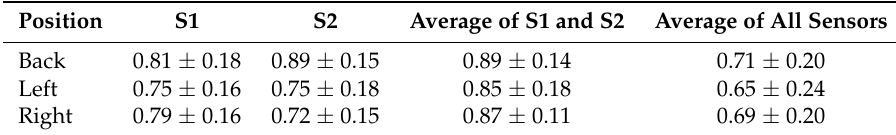
Table 2. Results of precision (average ± standard deviation).